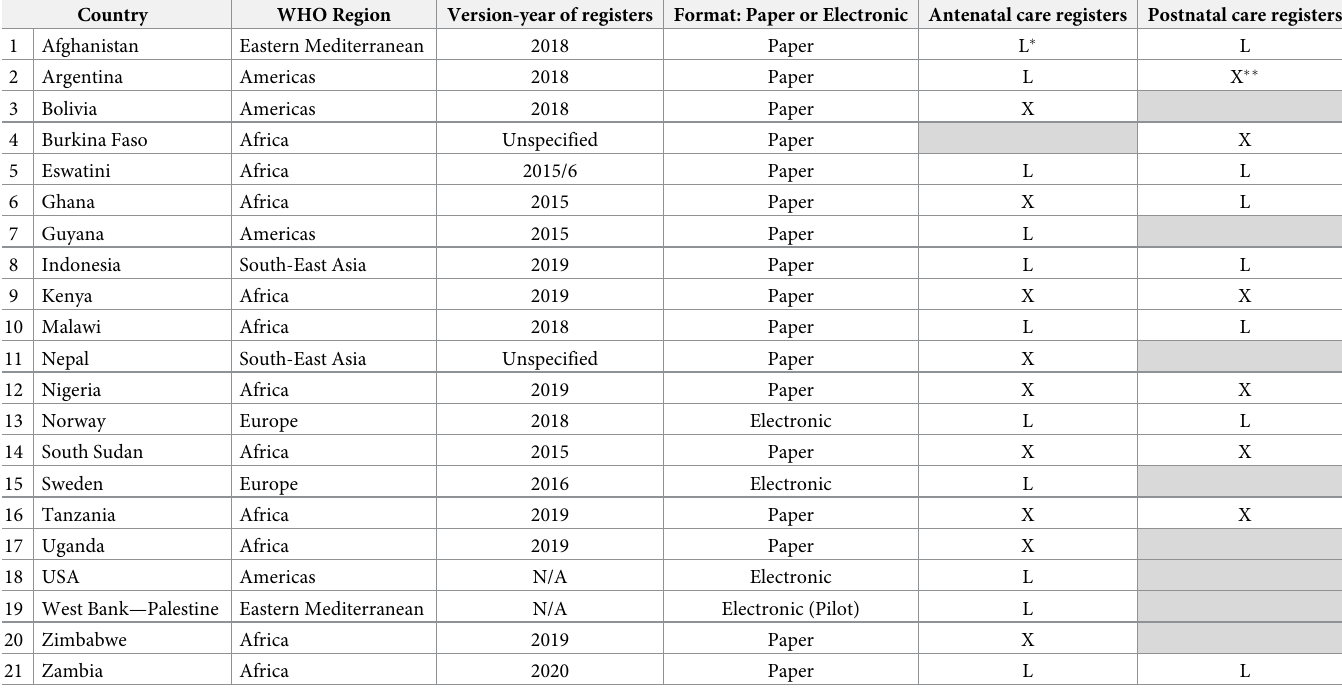
Table 1. Countries whose registers were included in the